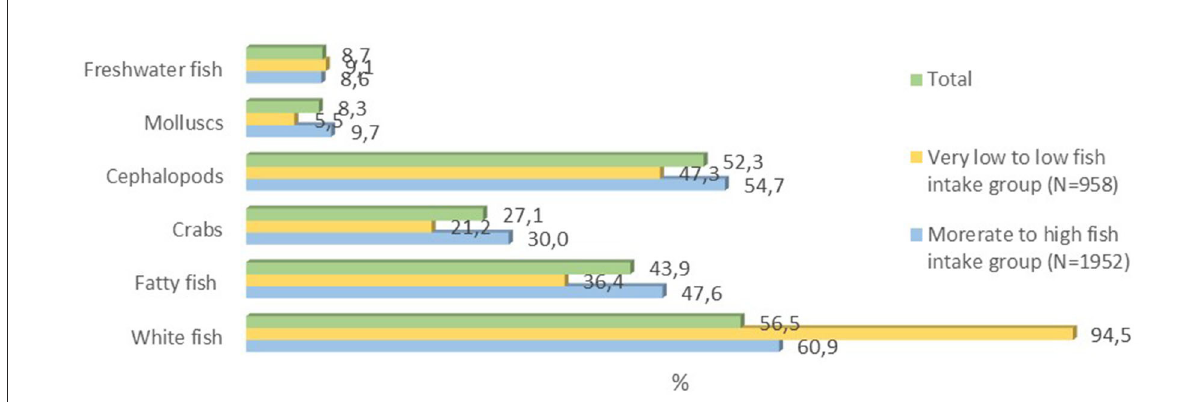
FIGURE2 Fishery products frequency consumption among groups regarding recommended fish intake ( N =